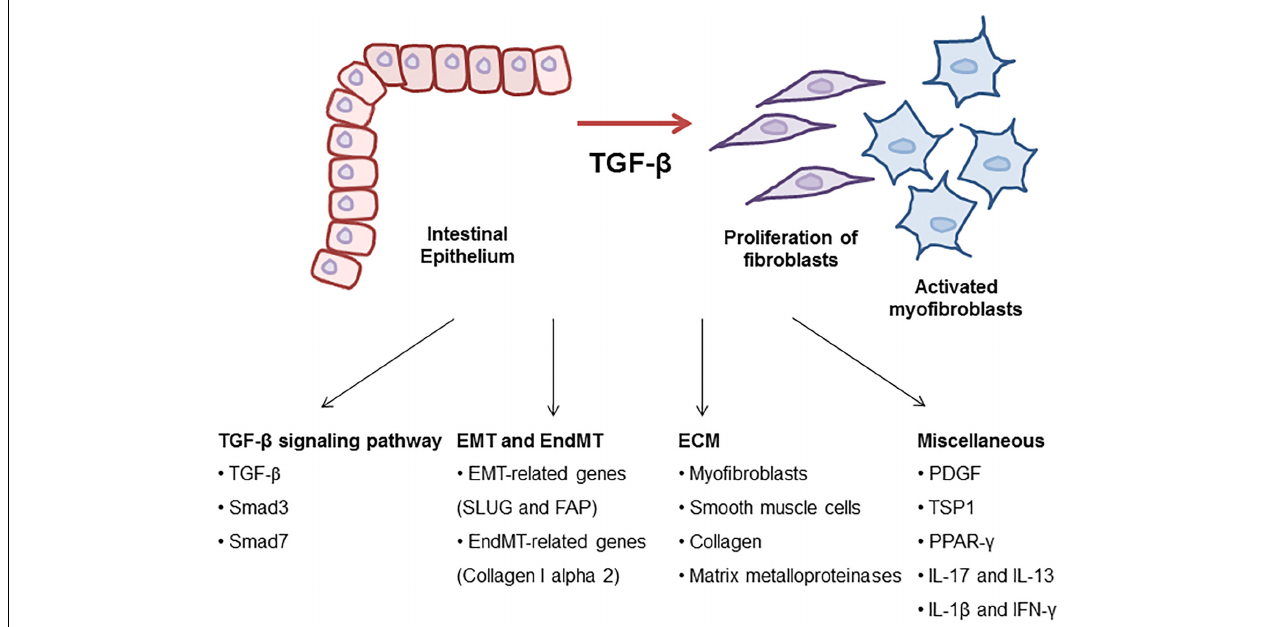
FIGURE 1 | Molecular mechanism of TGF- β signaling in intestinal fibrosis. TGF- β is a key regulator to drive intestinal fibrosis occurring in IBD. In the progression of fibrosis, TGF- β signaling-related genes including TGF- β , Smad3, and Smad7 are upregulated in patients with IBD. TGF- β induces EMT and EndMT-regulating genes resulting in the progression of intestinal fibrosis. Also, ECM synthesis, including the production of collagen and MMPs, is a characteristic of intestinal strictures and luminal stenosis and is a major therapeutic challenge for IBD. Many growth factors such as TGF- β induced ECM deposition by local fibroblasts and myofibroblasts differentiated by fibroblasts. Other cytokines (IL-17, IL-13, IL-1 β , and IFN- γ ) and TSP1 play roles as profibrotic mediators through the activation of fibroblasts in the development of intestinal fibrosis.